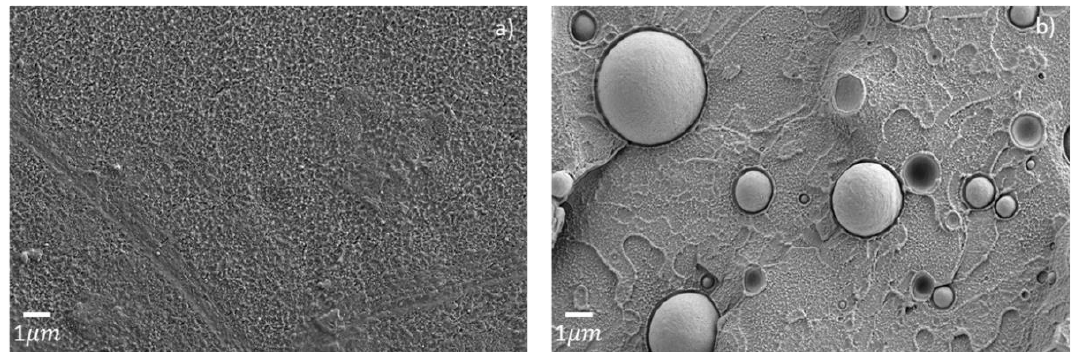
Figure 6. Electron micrographs of injected specimens ( a ) I-PET0 and ( b ) I-PET5.